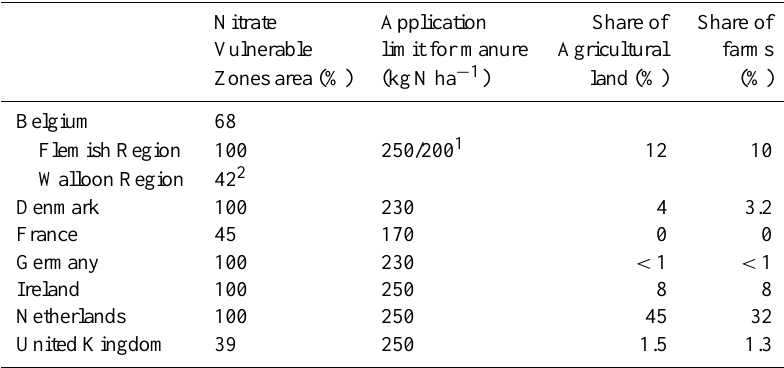
Table 7. Overview of area in Nitrate Vulnerable Zones and derogations for grassland (mostly dairy) farms in 2009 (European Commission, 2011). Nitrate Application Share of Share of Vulnerable limit for manure Agricultural farms Zones area (%) (kgNha − 1 ) land (%) (%) Belgium 68 Flemish Region 100 250/200 1 12 10 Walloon Region 42 2 Denmark 100 230 France